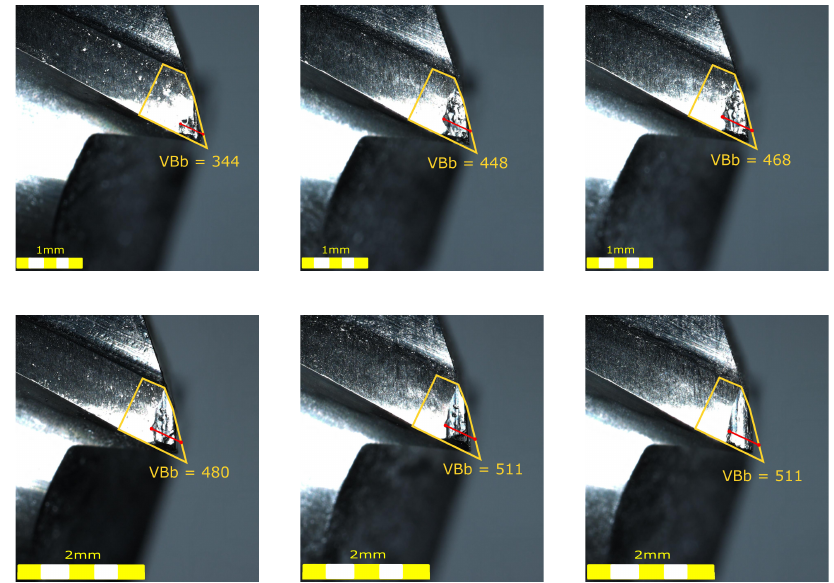
Figure 6. From left to right and top to bottom, flank wear measurement VBb (in µ m) conducted on: Flute 1 after milling Layer 03_02, Layer 05_02, Layer 06_01, Layer 07_02, Layer 08_01 and Layer